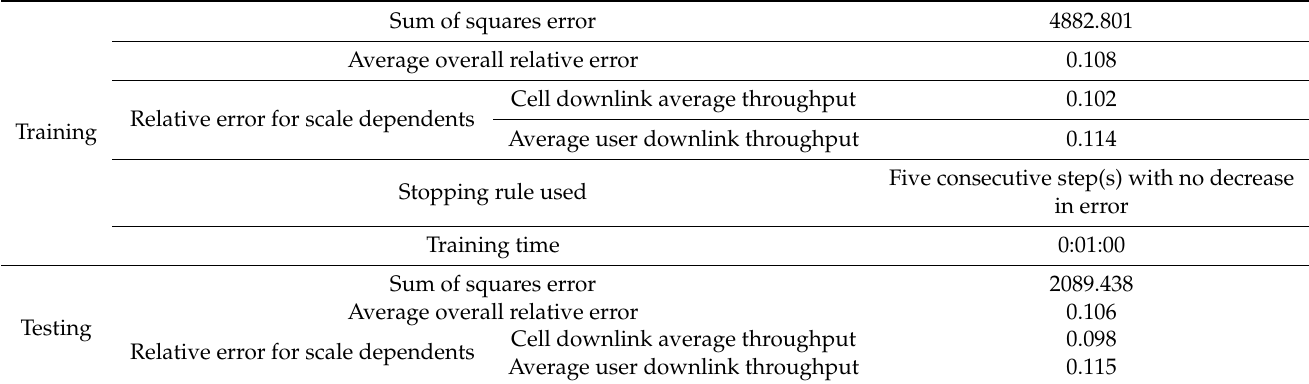
Table 9. The most important results of training and testing of the selected MLP